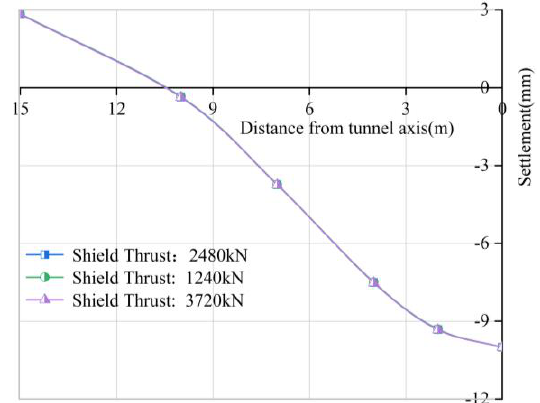
Figure 8. Influence of shield thrust on the lateral deformation of the ground surface.